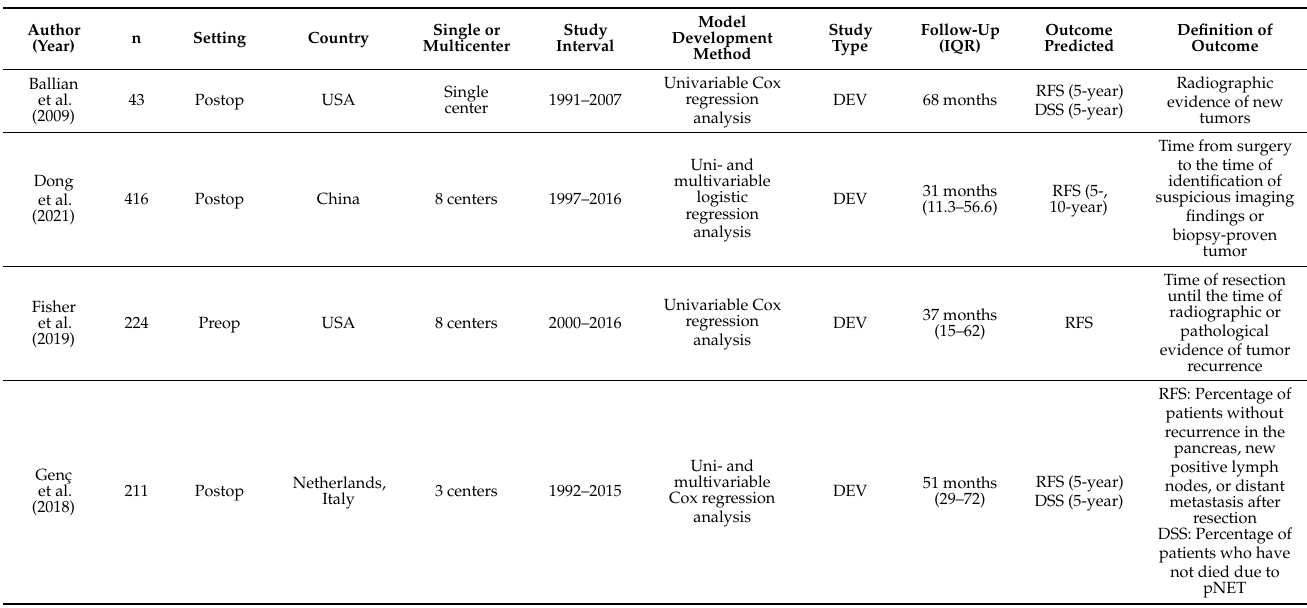
Table 1. Prediction model characteristics.